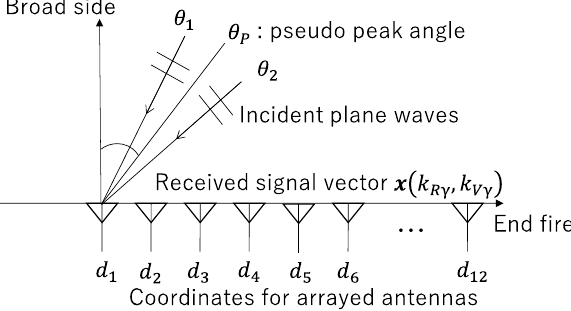
Figure 3. Definitions for the coordinates, incident waves and the antenna arrangement.